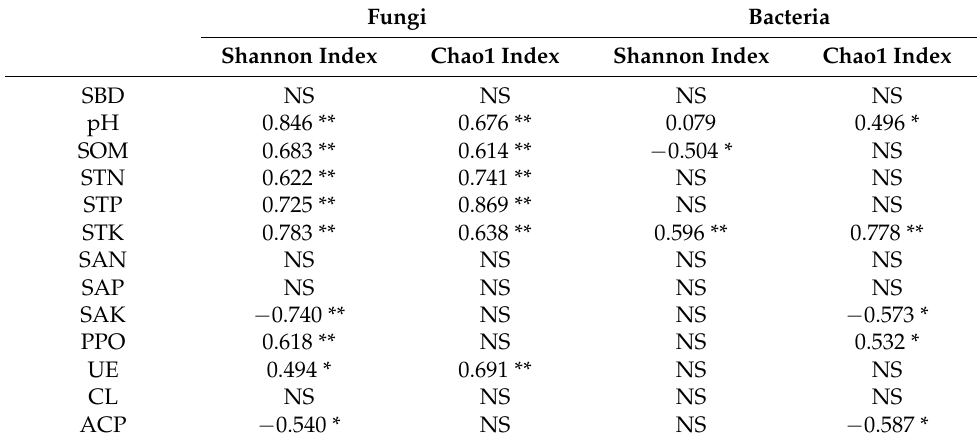
Table 6. Correlation analysis between soil microbial diversity and soil properties. Soil properties dates were the depths of 0–20 cm. Abbreviations are the same as Table 5. Asterisks represent